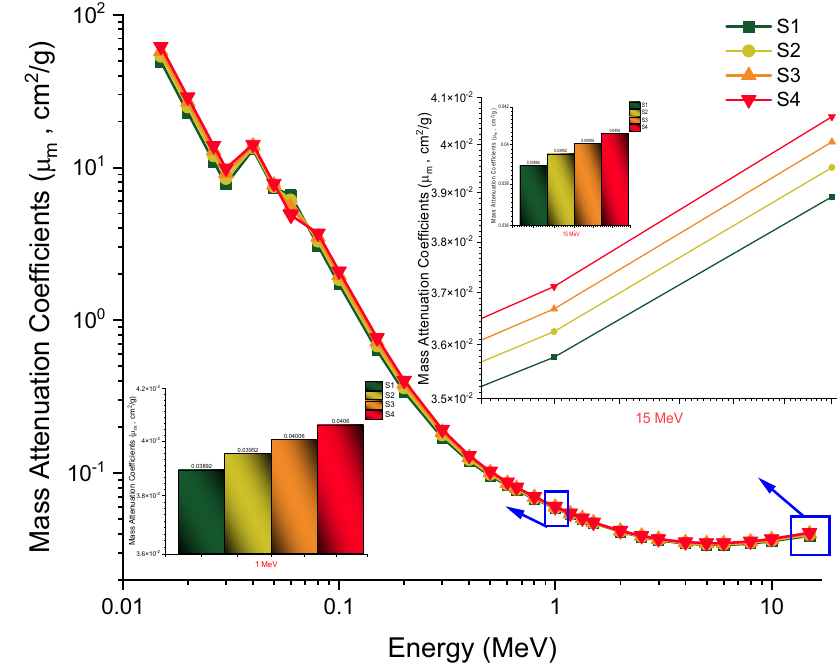
Figure 4: Variation in mass attenuation coe ffi cients ( cm 2 /g ) with photon energy ( MeV ) for all S1 – S4